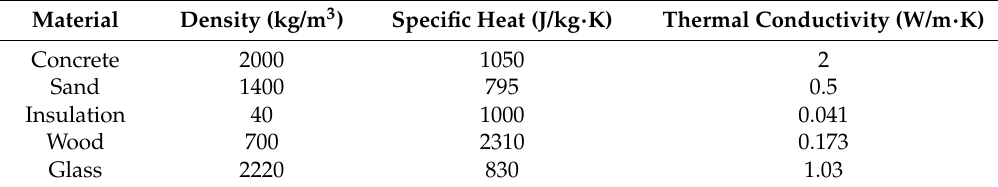
Table 1. Properties of the